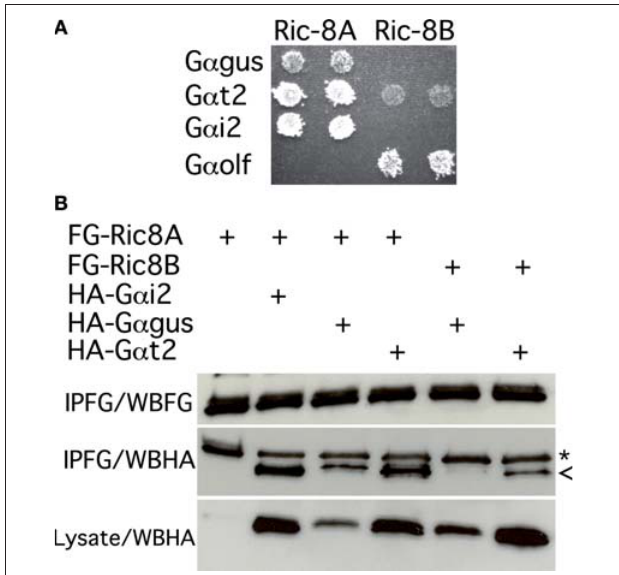
FIGURE 4 | Gustducin interacts with Ric-8A, but not Ric-8B. (A) Yeast two hybrid interaction assay. Mav203 yeasts cells were co-transformed with different combinations of bait (G α olf, G α t2, G α gus or G α i2) and prey (Ric-8A or Ric-8B) plasmids. Interaction was scored on minimal medium plates containing 3-AT and lacking histidine and tryptophan. Growth refl ects the strength of the interaction. (B) Co-immunoprecipitation experiment showing the association between Flag-Ric-8A and HA-G α i2 or HA-G α gus. (*) denotes an artifact band (IgG) while ( < ) correspond to the G α subunit band. IPFG: immunoprecipitation using an anti-Flag antibody; WBFG: western blotting membrane incubated with an anti-Flag antibody; WBHA: western blotting membrane incubated an anti-HA antibody.